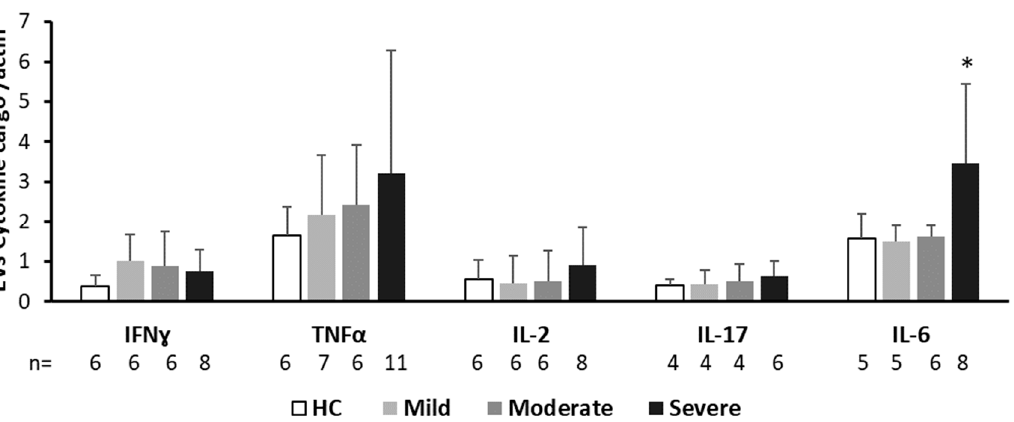
Figure 7. EV cytokine cargo. The expression of cytokines in the EV cargo was determined by Western blot. EV pellets were isolated from the HC group and from the three COVID-19 subgroups. The graph presents the mean ± standard deviation of each protein in the EV pellet: INF Υ , TNF α , IL-6, IL-2, and IL-17. They are expressed as a ratio of actin that served as an unchanged control. Gel images are provided in Supplementary Figure SM1. * p < 0.05